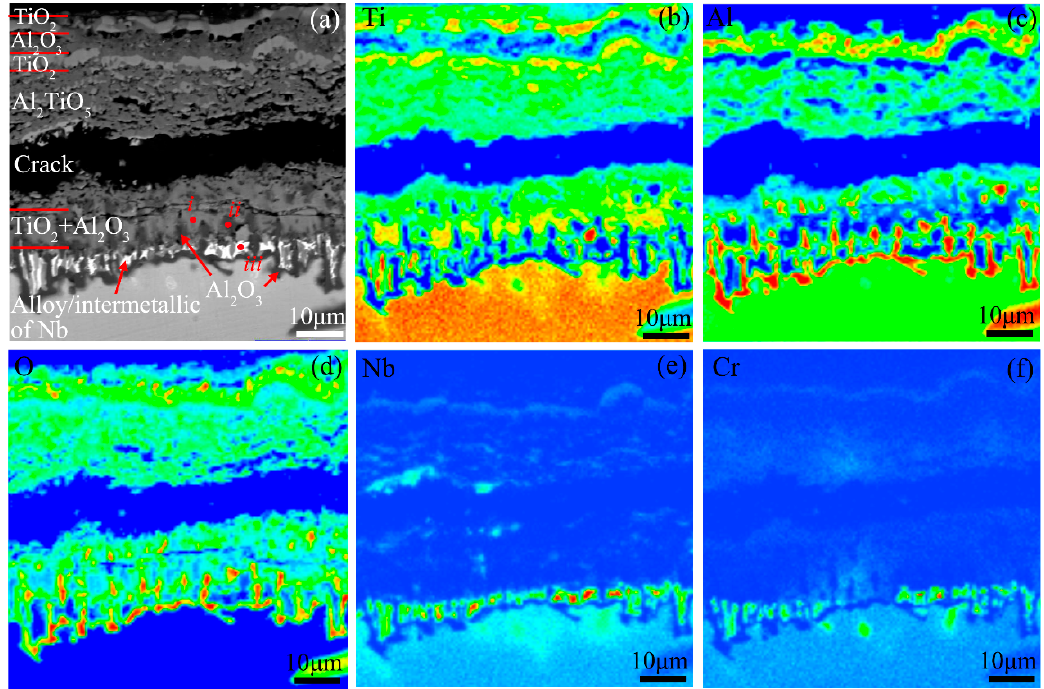
Figure 14. ( a ) Cross-sectional morphology and ( b – f ) the corresponding elemental distribution maps of the oxide scale formed during heating the Ti-46Al-2Cr-5Nb alloy to the end of Stage V. Table 3. Chemical compositions of the microstructures in the inner layer of the oxide and in the subsurface of the Ti-46Al-2Cr-5Nb alloy examined by EPMA after heating the alloy to the end of Stage IV. Compositions (at.%) Microstructures in Figure 14a